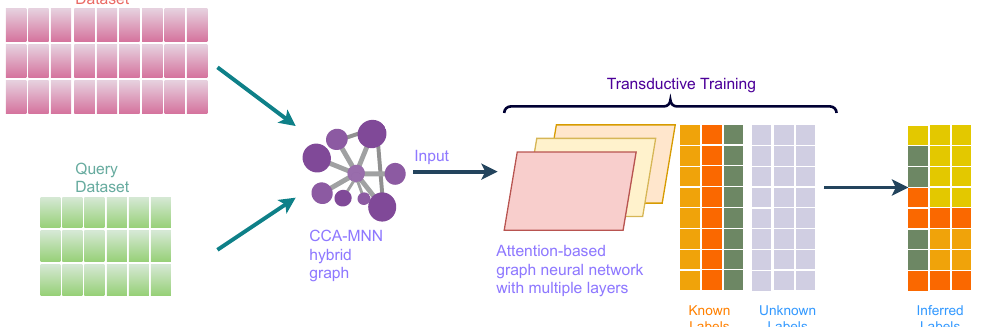
Figure 3. An illustration of scAGN. It shows the concept behind transductive training on the CCA- MNN graph using Attention-based Graph Neural Network architecture. The reference and query datasets are jointly processed to create a feature set that is used to calculate CCA-MNN hybrid graph representation in a sparse edge format. The graph is used as an input along with true labels for reference datasets to the attention-based graph neural network for training. The trained model can be used for making a prediction on an unseen